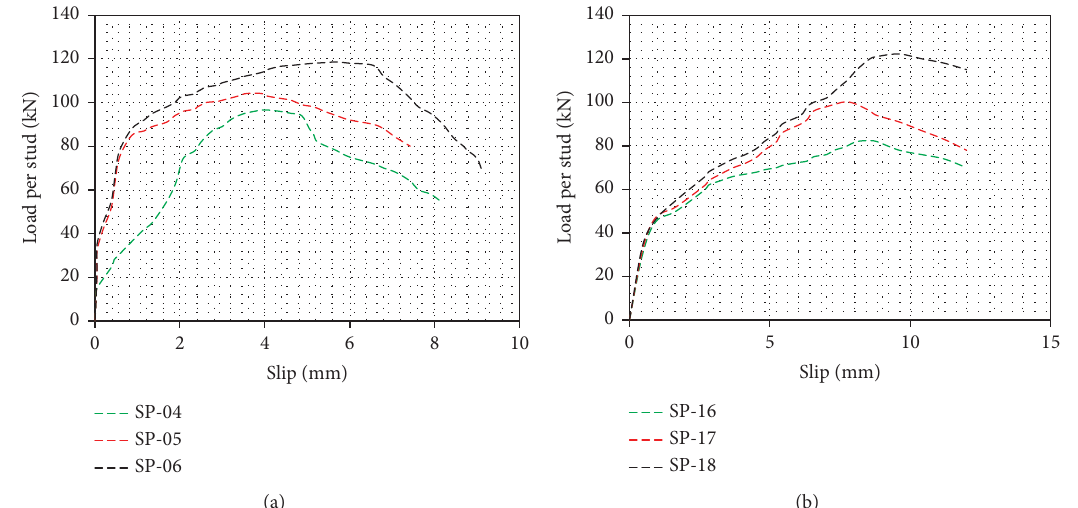
Figure 12: Effects of concrete strength on the capacity of shear connection with (a). Open through and (b). Reentrant profiled steel sheeting with C-40, C-50, and C-60